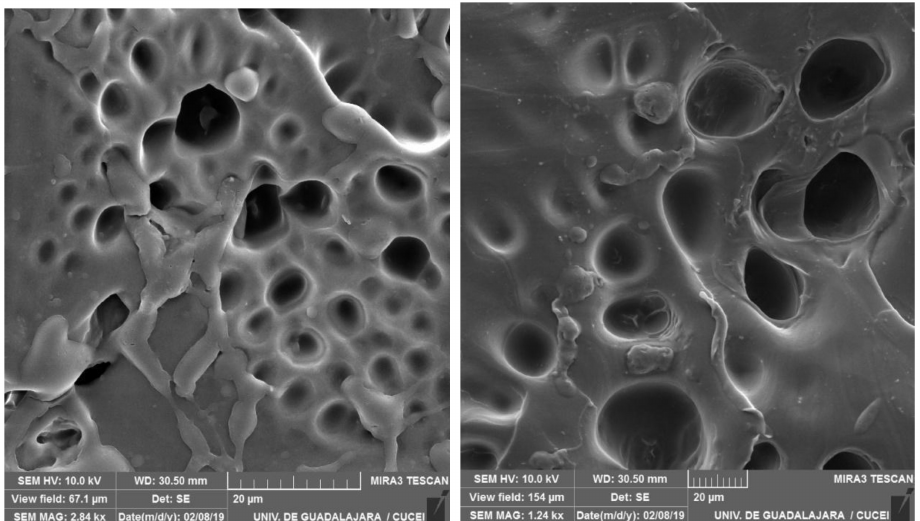
Figure 5. Scanning electron microscopy image of hydrogel swelling